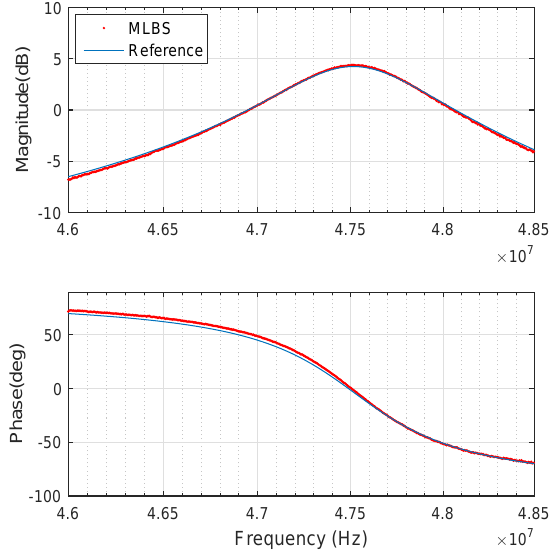
Figure 9: Output impedance of the resonator using MLBS and sine sweep